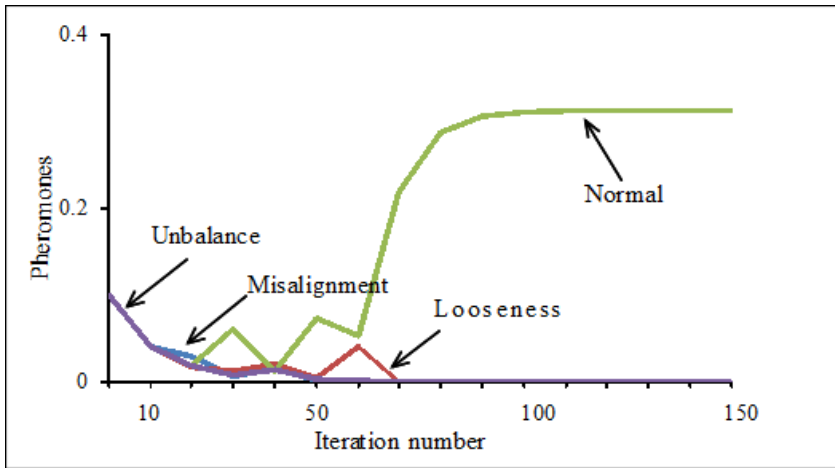
Figure 9. Pheromones for distinguishing the normal state from abnormal